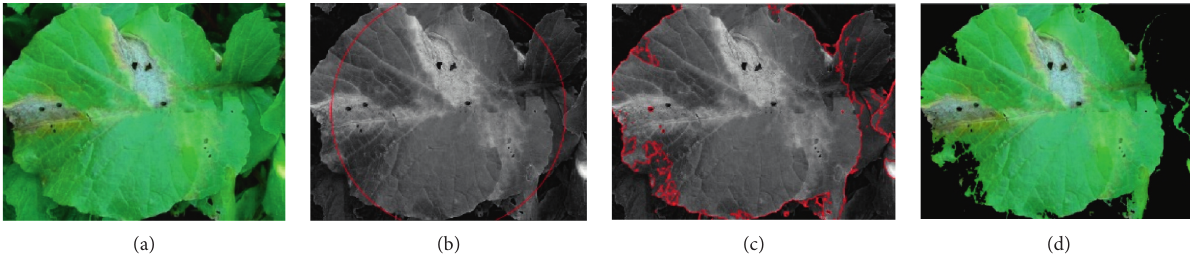
Figure 3: The result of Chan–Vese algorithm segmenting black rot diseased leaf: (a) image capture; (b) initial zero level set; (c) contour image after 500 iterations; (d) segmentation results.